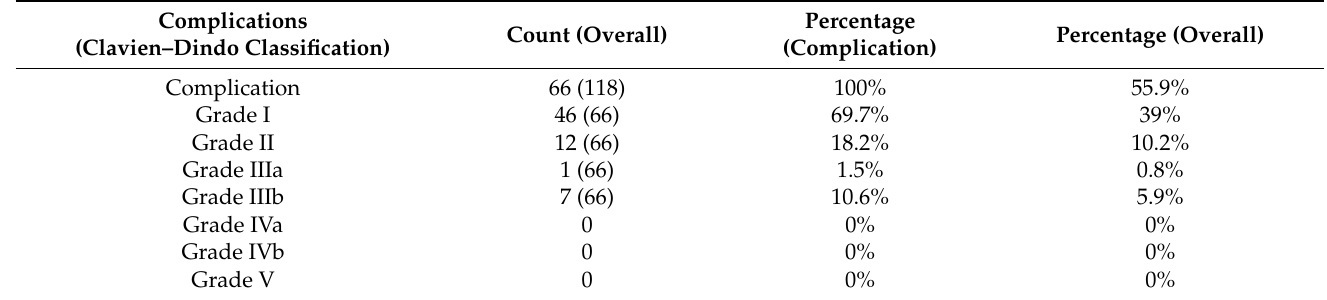
Table 1. Patients’ information regarding complications. Out of 118 patients, 66 (55.9%) developed a complication.